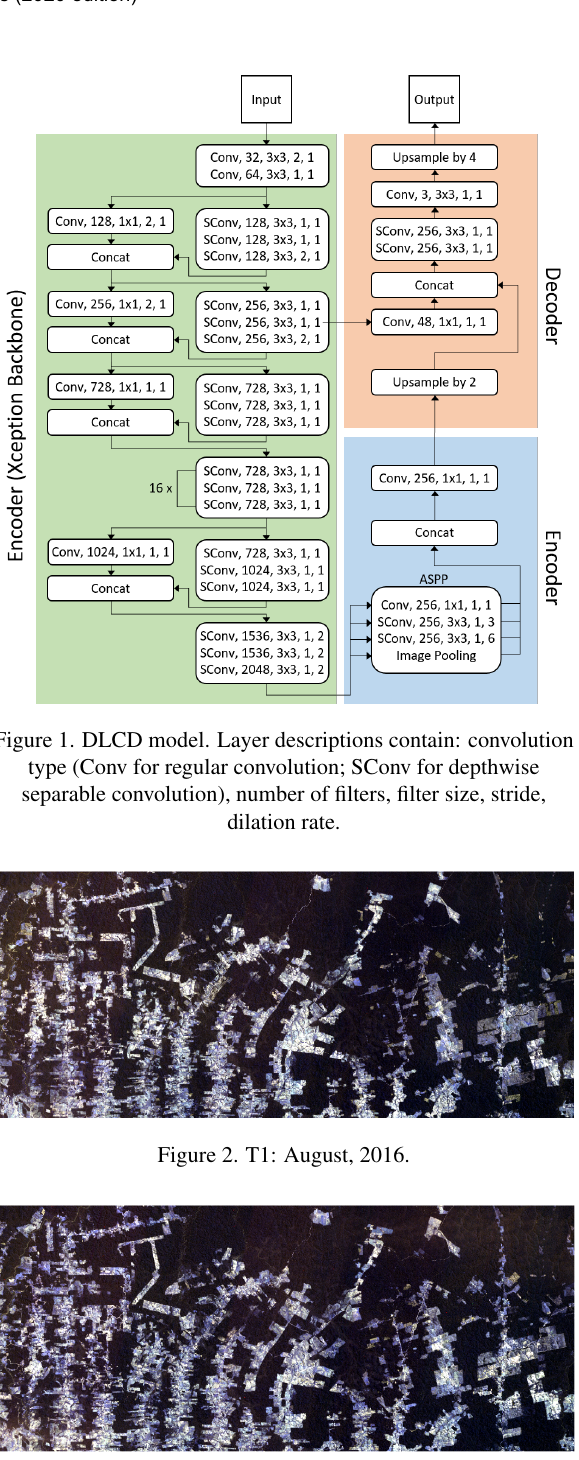
Figure 3. T2: July,